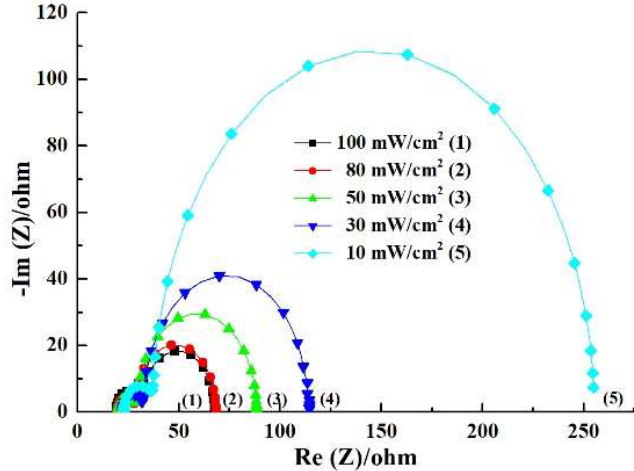
Figure 13. Nyquist plots for DSSCs based on TiO 2 under di ff erent illuminations.